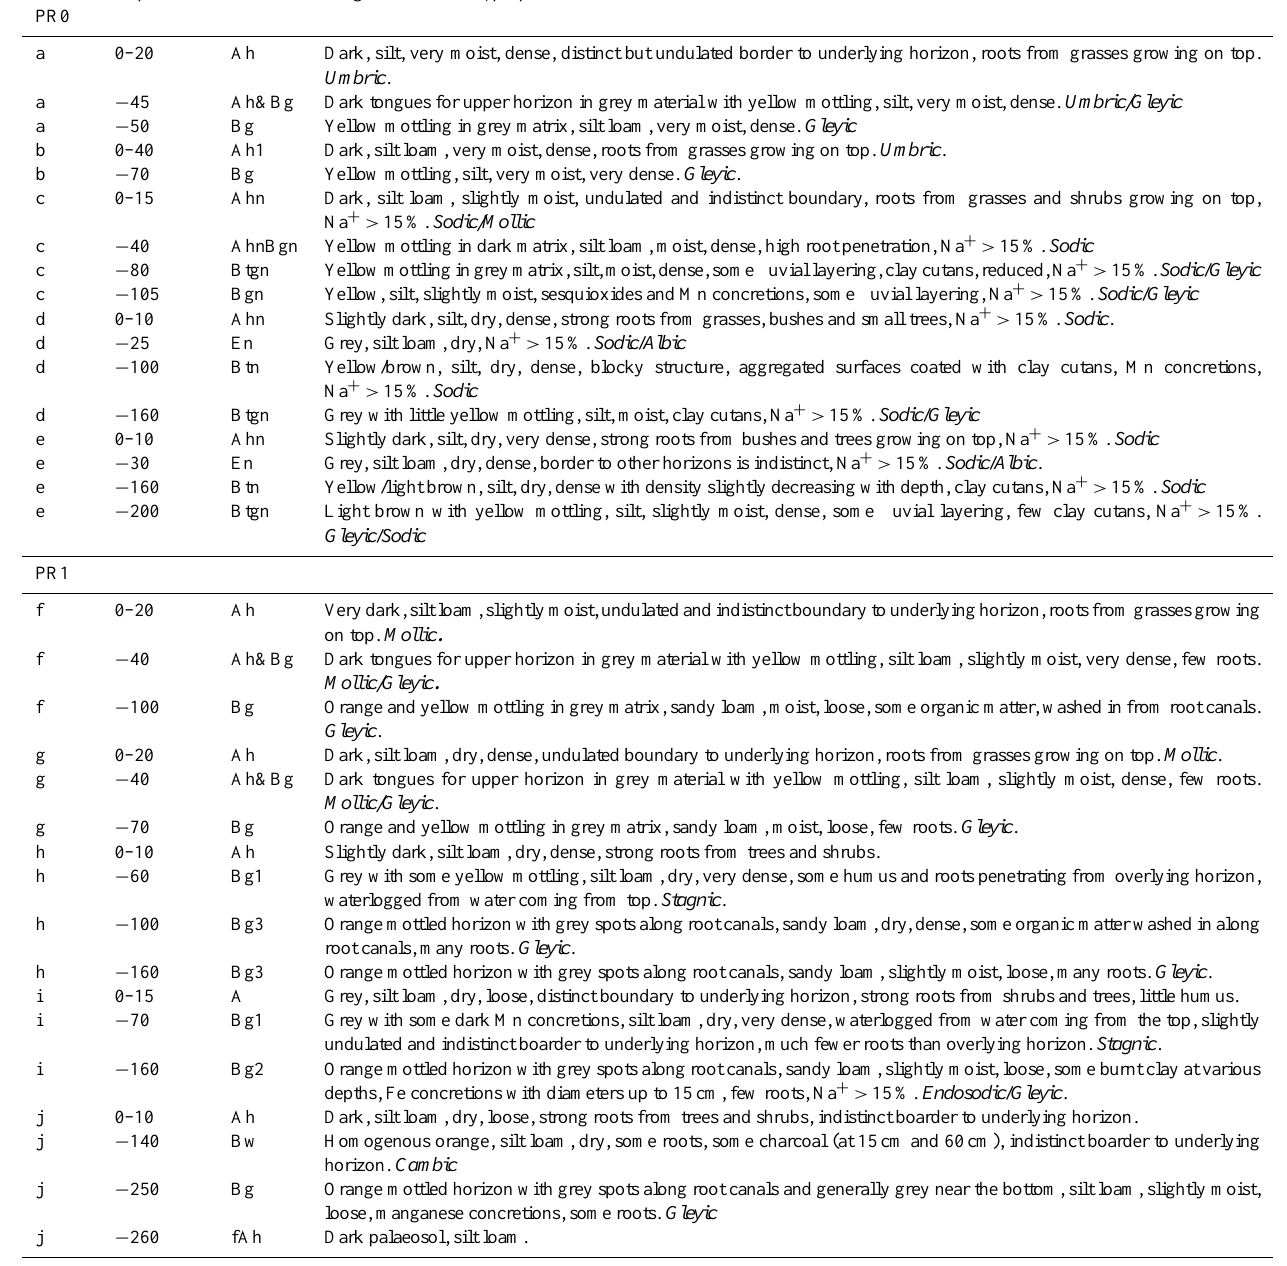
Table 1. Soil profiles and diagnostic horizons based on FAO-WRB (2006), PR0: a, Umbric Gleysol; b, Umbric Gleysol; c, Sodic Luvisol; d, Sodic Luvisol; e, Sodic Luvisol; f, Mollic Gleysol; g, Mollic Gleysol; h, Stagnic Gleysol; i, Endosodic Stagnic Gleysol; j, Cambisol. See also Figs. 5, 6 and 7.